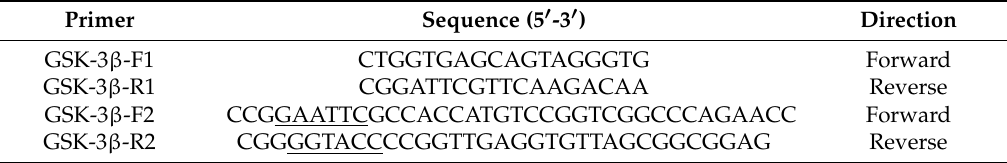
Table 1. Sequence of the primers used in this